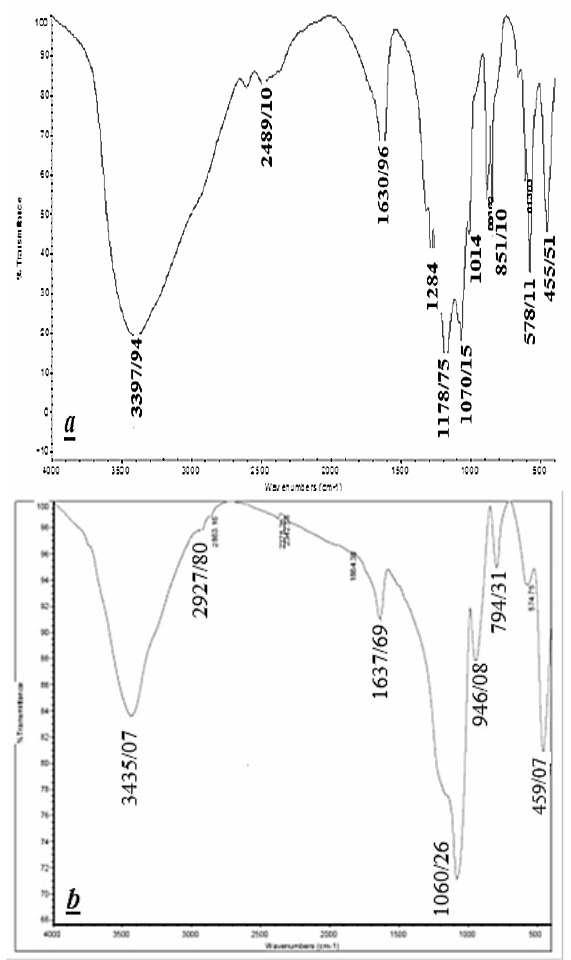
@FeSO nanoparticles. 2 4